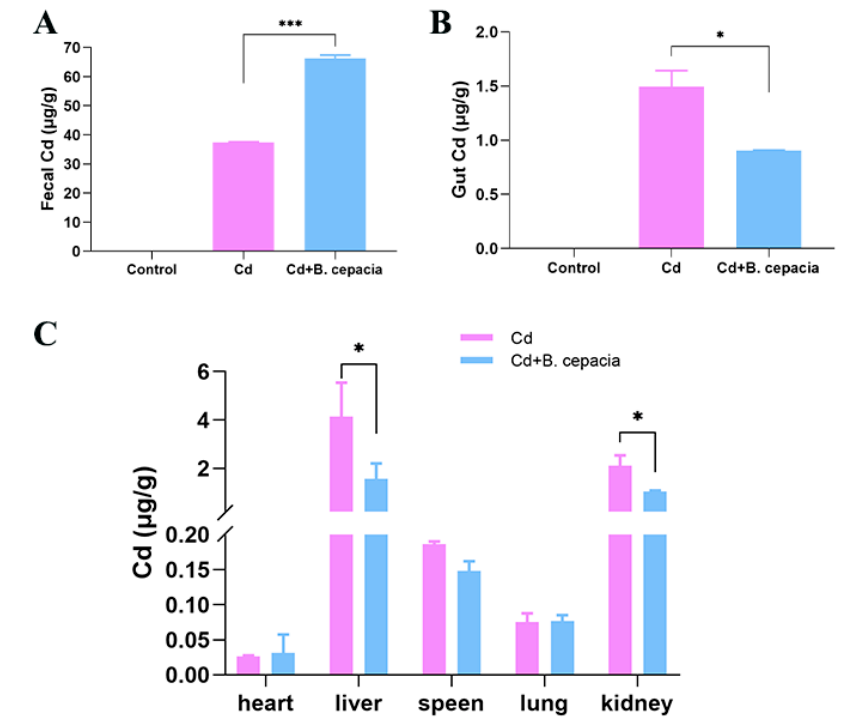
Figure 3. Cd accumulation in Cd-exposed mice. ( A ) Total Cd content in feces; ( B ) Cd content in the gut; ( C ) Cd contents in the heart, liver, spleen, lung, and kidneys after treatment for 7 d. * p < 0.05 and *** p < 0.001 versus the Cd group.